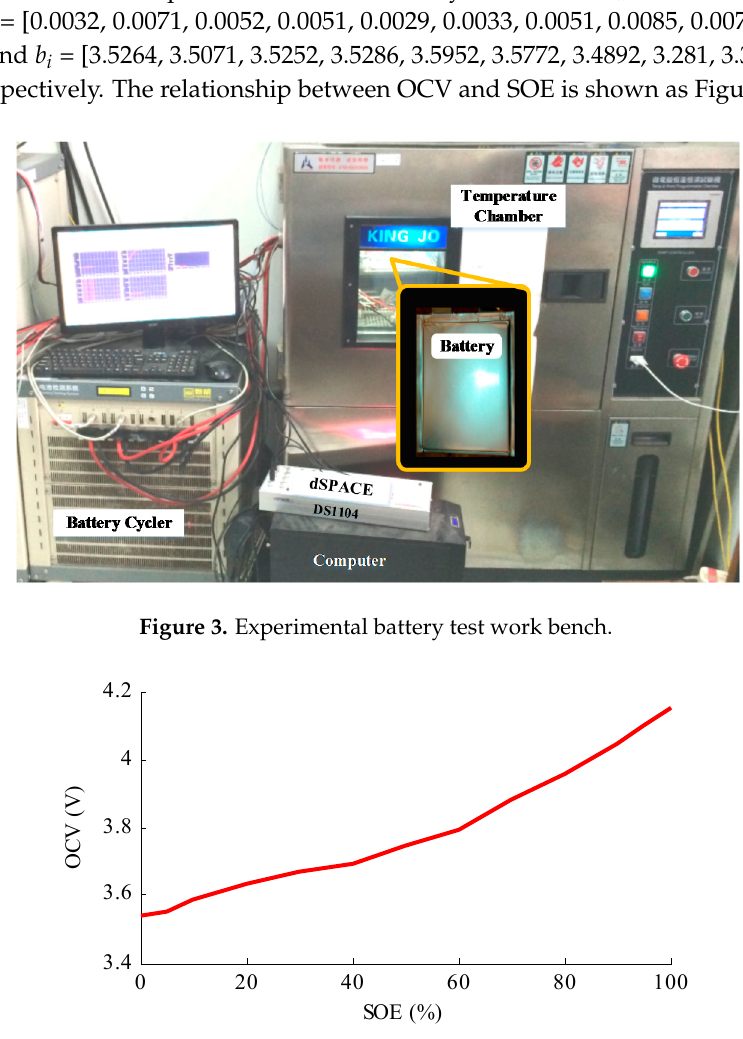
Figure 4. The relationship between OCV and SOE.